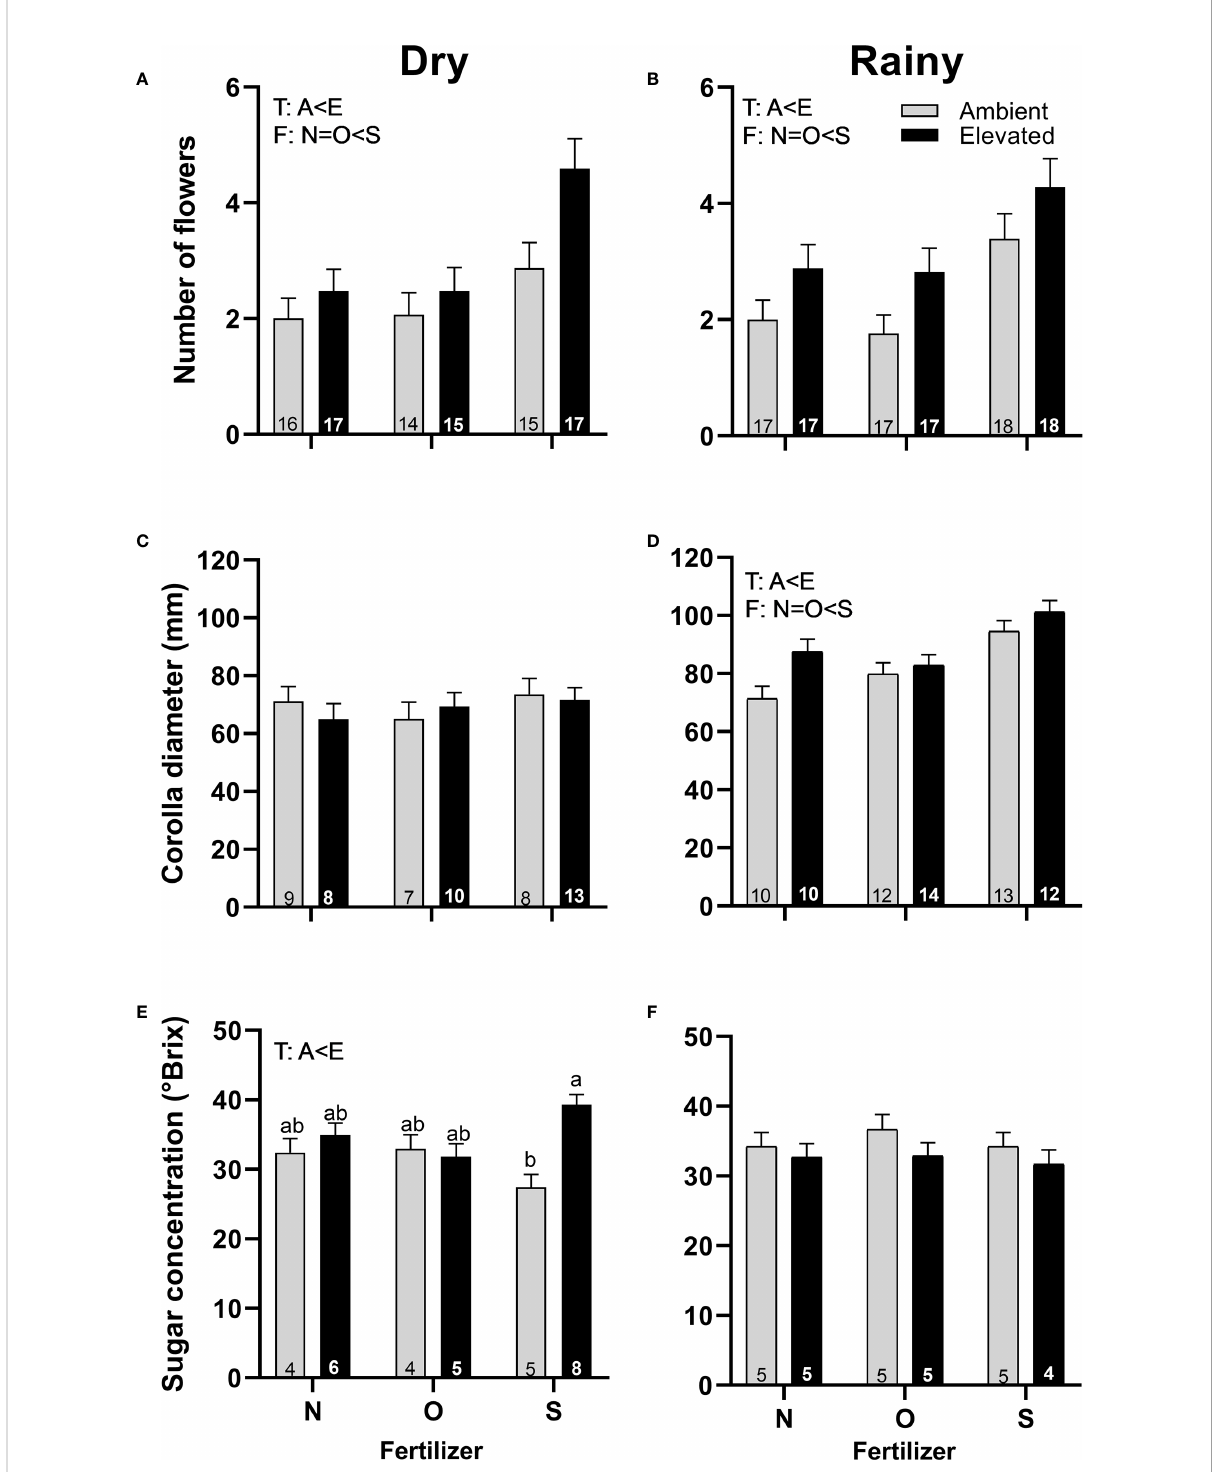
FIGURE 3 Effects of the increase in temperature (T) and addition offertilizer (F) on the number of fl owers (A, B) , corolla diameter (C, D) and sugar concentration (E, F) of pistillate fl owers of C. pepo during the dry (left) and the rainy (right) season (mean ± SE; n: number inside bar). Signi fi cant differences in the main factors (T or F) are represented with capital letters (A, ambient temperature; E, elevated temperature; N, no supplementary fertilizer; O, organic fertilizer; S, synthetic fertilizer). Different lower-case letters above bars indicate statistically signi fi cant T x F interactions. Mean and standard deviation values are in Supplementary Tables 1, 2 and the results of the statistical tests are summarized in Supplementary Table